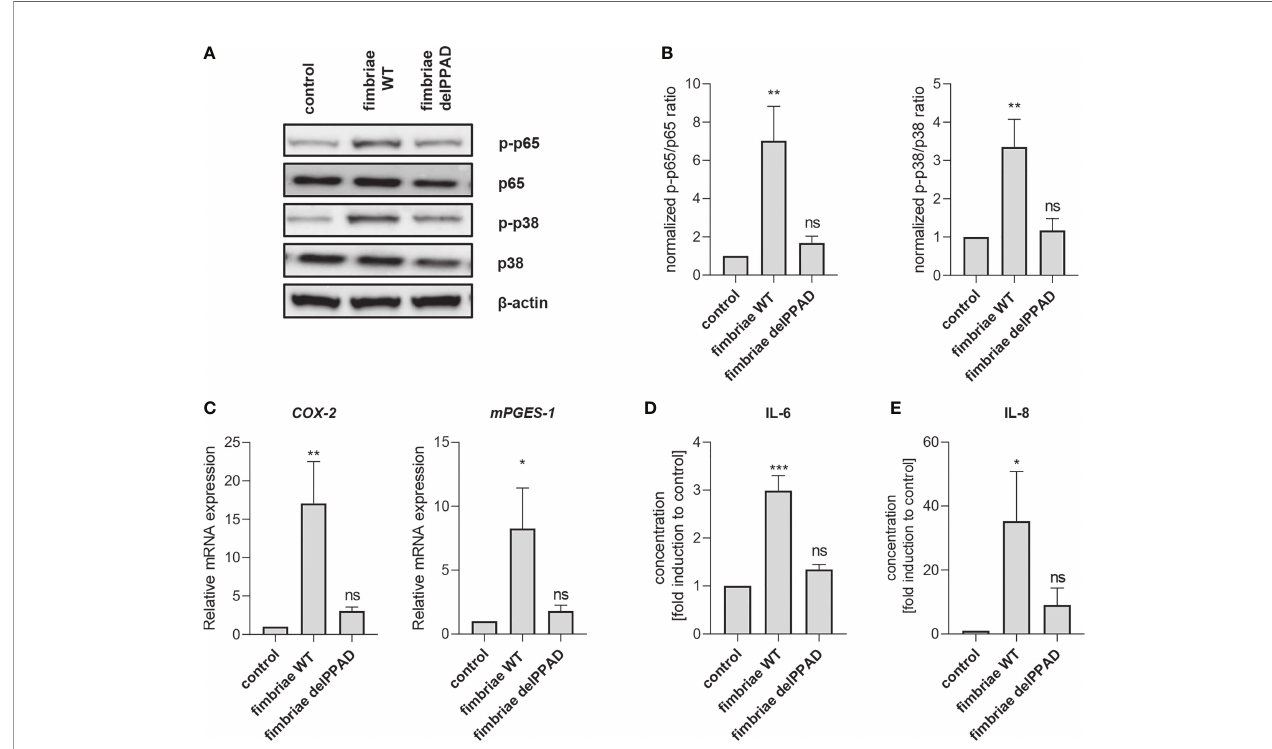
FIGURE 6 | Fimbriae puri fi ed from the WT-ATCC 33277 strain stimulate PHGFs to produce cytokines and activate the NF- ĸ B and MAPK kinase signaling pathways. (A, B) Western blot analysis of phosphorylated and total p65 and p38 in PHGFs (n=7) treated for 1 h with puri fi ed fi mbriae (10 µg/ml) isolated from WT-ATCC 33277 (FimA WT) or its isogenic PPAD mutant (FimA delPPAD). b -actin was used as a control. (A) Representative blots and (B) results of densitometry analysis are shown. (C) Expression of mRNA encoding PGE2 synthesis-related genes COX-2 and mPGES-1 in PHGFs (n=7) treated for 4 h with puri fi ed fi mbriae (10 µg/ml) isolated from WT-ATCC 33277 strain (FimA WT) or its isogenic PPAD mutant (FimA delPPAD). (D, E) Secretion of IL-6 (D) and IL-8 (E) by PHGFs (n=5) treated for 24 h with puri fi ed fi mbriae (10 µg/ml) from WT and delPPAD ATCC 33277 strains. Data represent the mean ± SEM normalized phosphorylated to total protein ratio (B) , relative mRNA expression (C) or fold change of cytokine concentration (D, E) ; ***p < 0.001; **p < 0.01; *p < 0.05; ns, no statistical signi fi cance; 1-way ANOVA followed by Tukey ’ s multiple comparisons test; “ n ” represents the number of independent experiments performed on PHGFs cell lines derived from different healthy